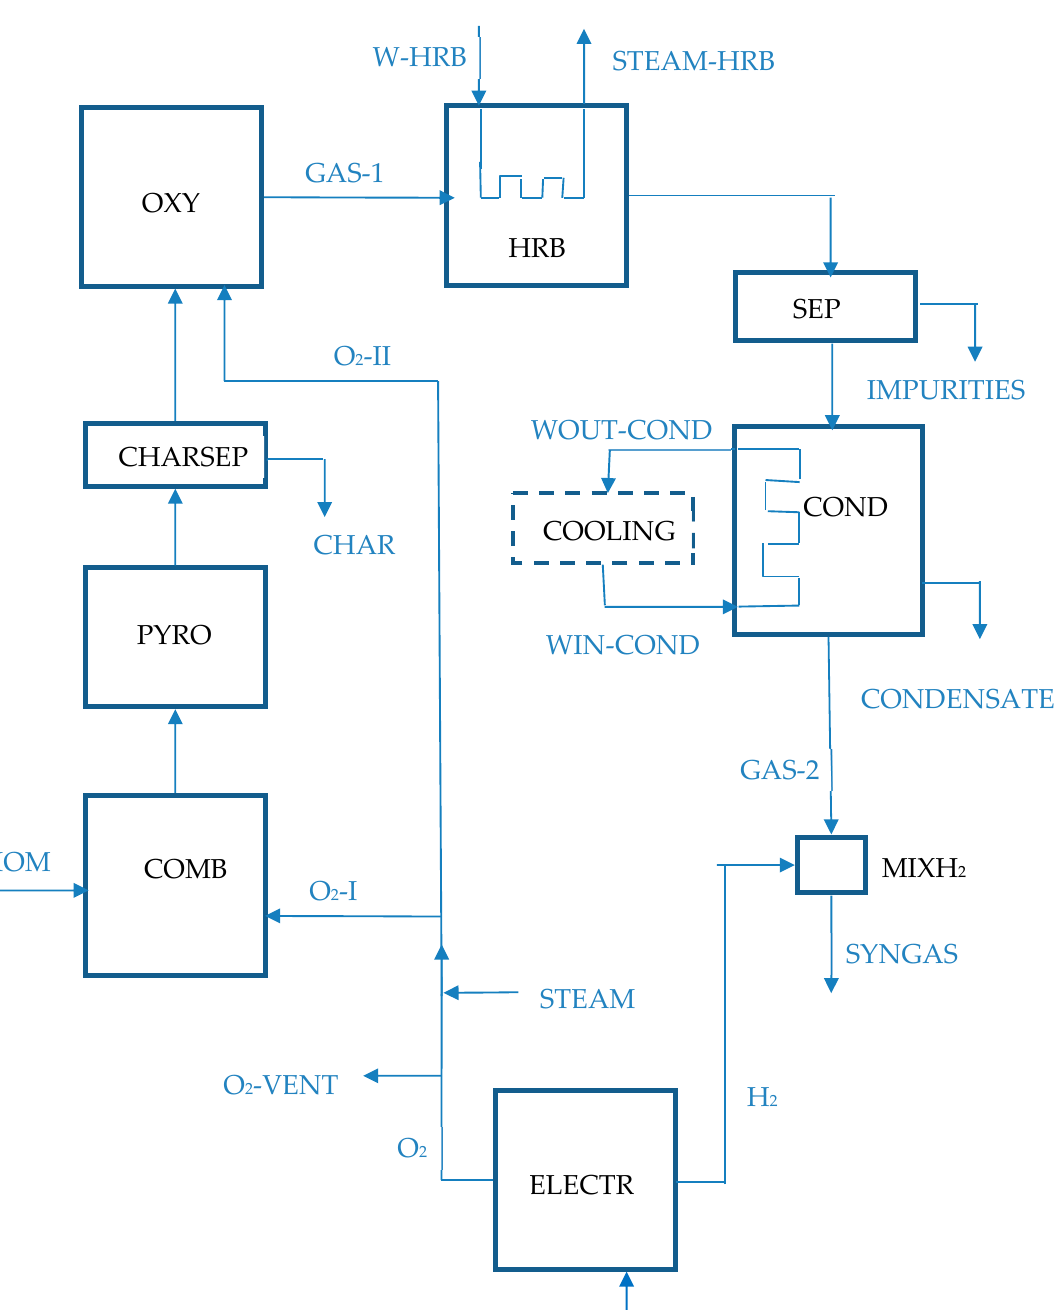
Figure 3. Block calculation diagram.